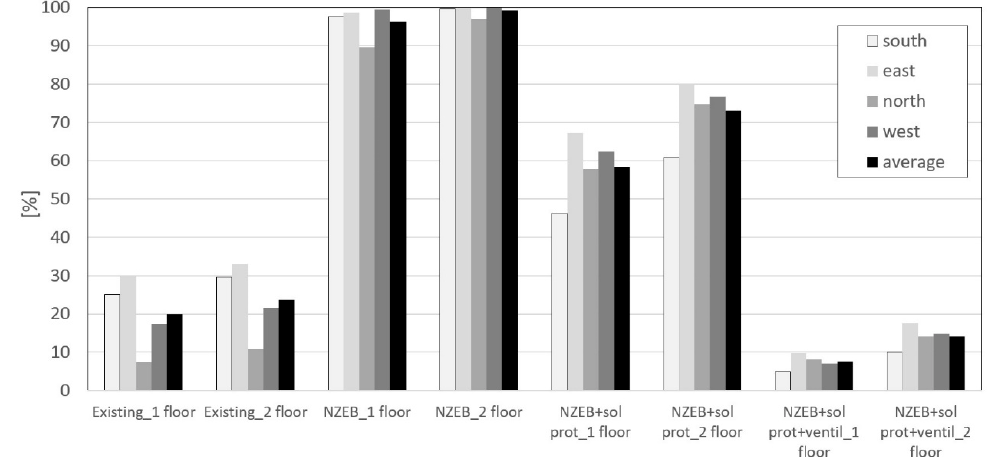
Figure 6. Relative discomfort hours of the different building configurations in Rome.